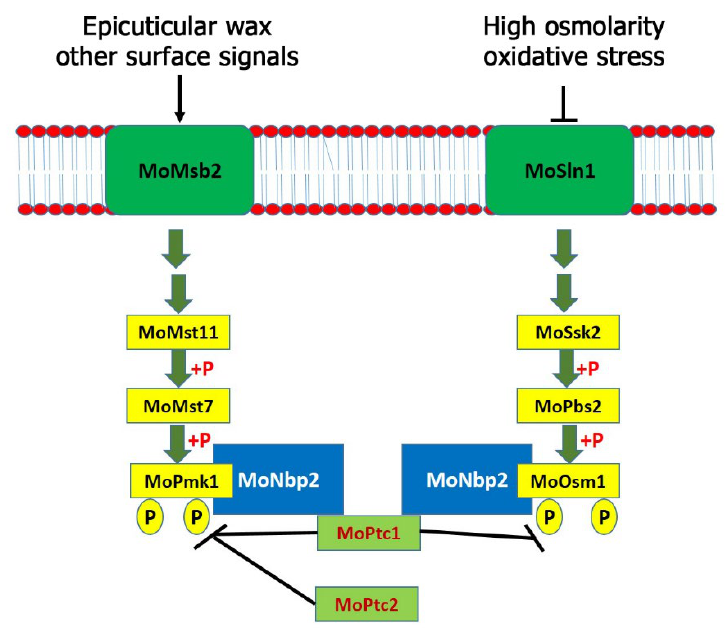
Figure 5. A model showing regulation of MAPK signaling pathways by MoPtc1 and MoPtc2 in M. oryzae . The Pmk1 pathway is essential for appressorium formation and invasive growth in this fungus. We identified MoPtc1 and MoPtc2 as negative regulators of the MoPmk1-MAPK in M. oryzae . The Osm1 pathway was activated during high osmolarity and oxidative stress and played crucial role in osmotic stress response. This pathway was negatively regulated by MoPtc1 and positively regulated by MoPtc2. The MoPtc1 interacted with MoOsm1-MAPK through the adaptor protein MoNbp2 both in vitro and in vivo.